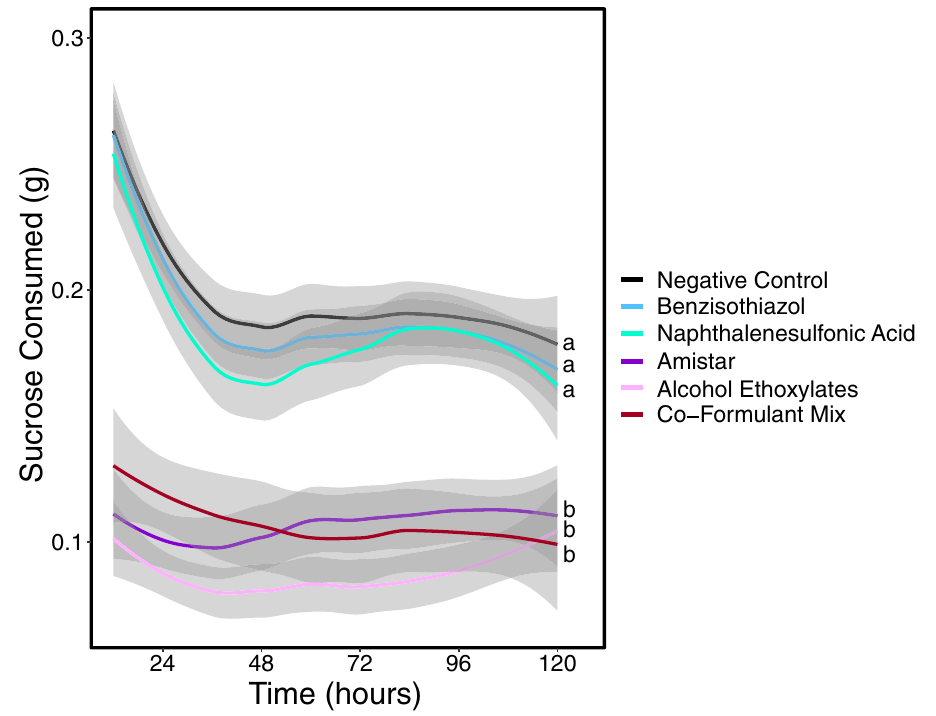
Figure 2. A time series plot showing sucrose consumption over a 120-h period; colour coded by treatment. Average consumption and 95% confidence intervals are shown. Sucrose consumption data collected every 12 h has been LOESS smoothed. Y axis scale refers to sucrose consumption per bee over a 12-h period. Different letters indicate statistically significant